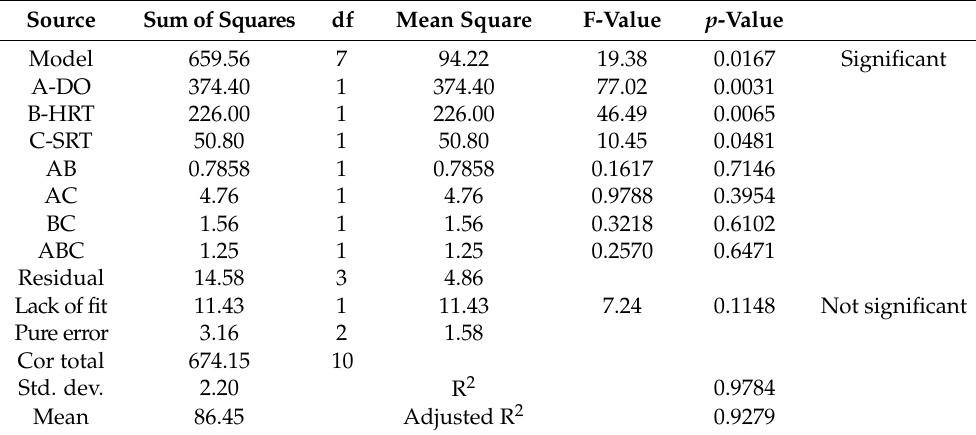
Table 5. ANOVA results for COD removal response.